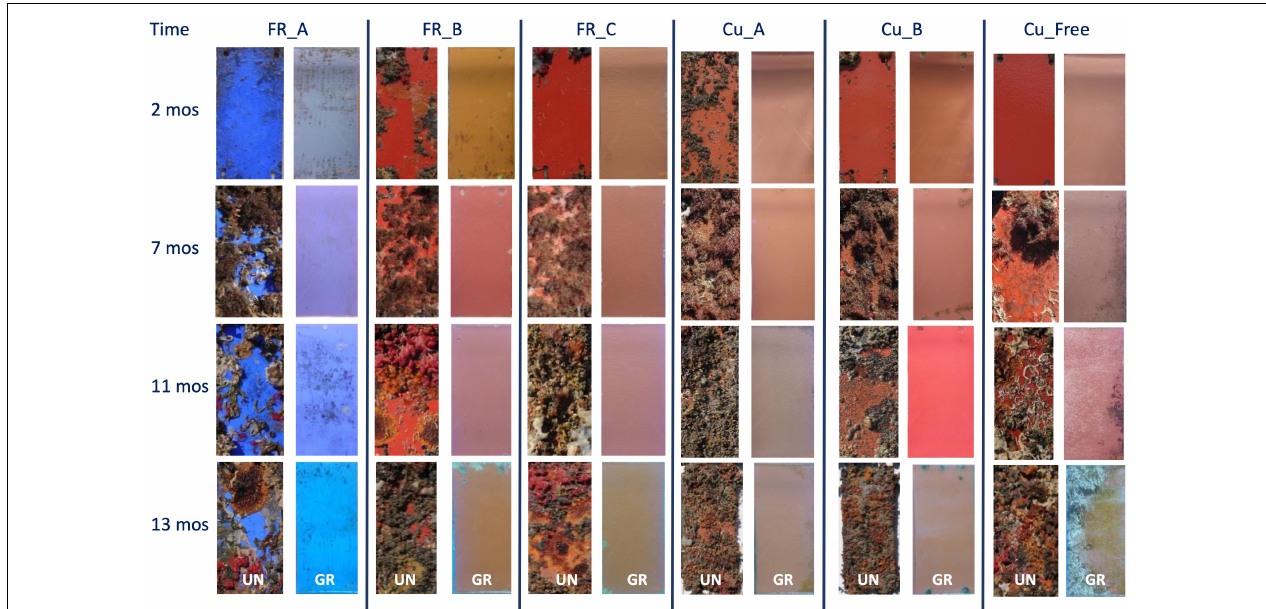
FIGURE 12 | The progression of fouling on three fouling release coatings and three biocide-based coatings subjected to static immersion: ungroomed vs. groomed once a